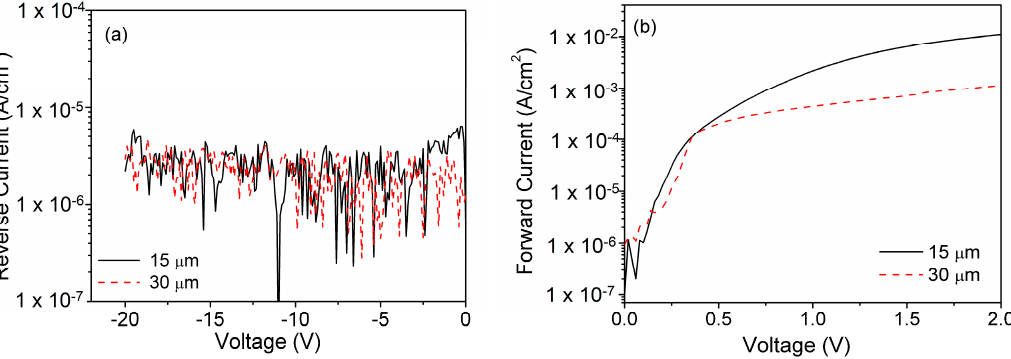
Figure 10. ( a ) Reverse and ( b ) Forward I-V characteristics of SBDs with 15 µ m and 30 µ m GaN DL.